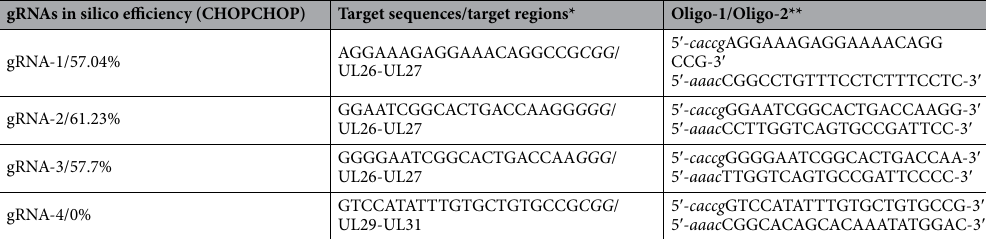
Table 1. DNA oligonucleotides used to construct gRNA plasmids. *gRNA sequences (20 nucleotides) followed by PAM-3 ′ (italics capital letters). **5 ′ -caccg (Oligo-1) and 5 ′ -aaac (Oligo-2) (italics small letters) overhangs were added to gRNA oligos to clone these oligos into CRISPR